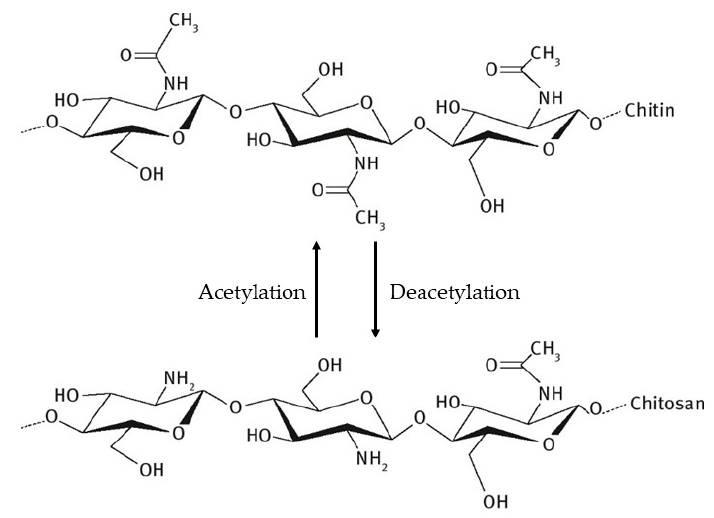
Figure 1. Chemical structures of chitin and chitosan.